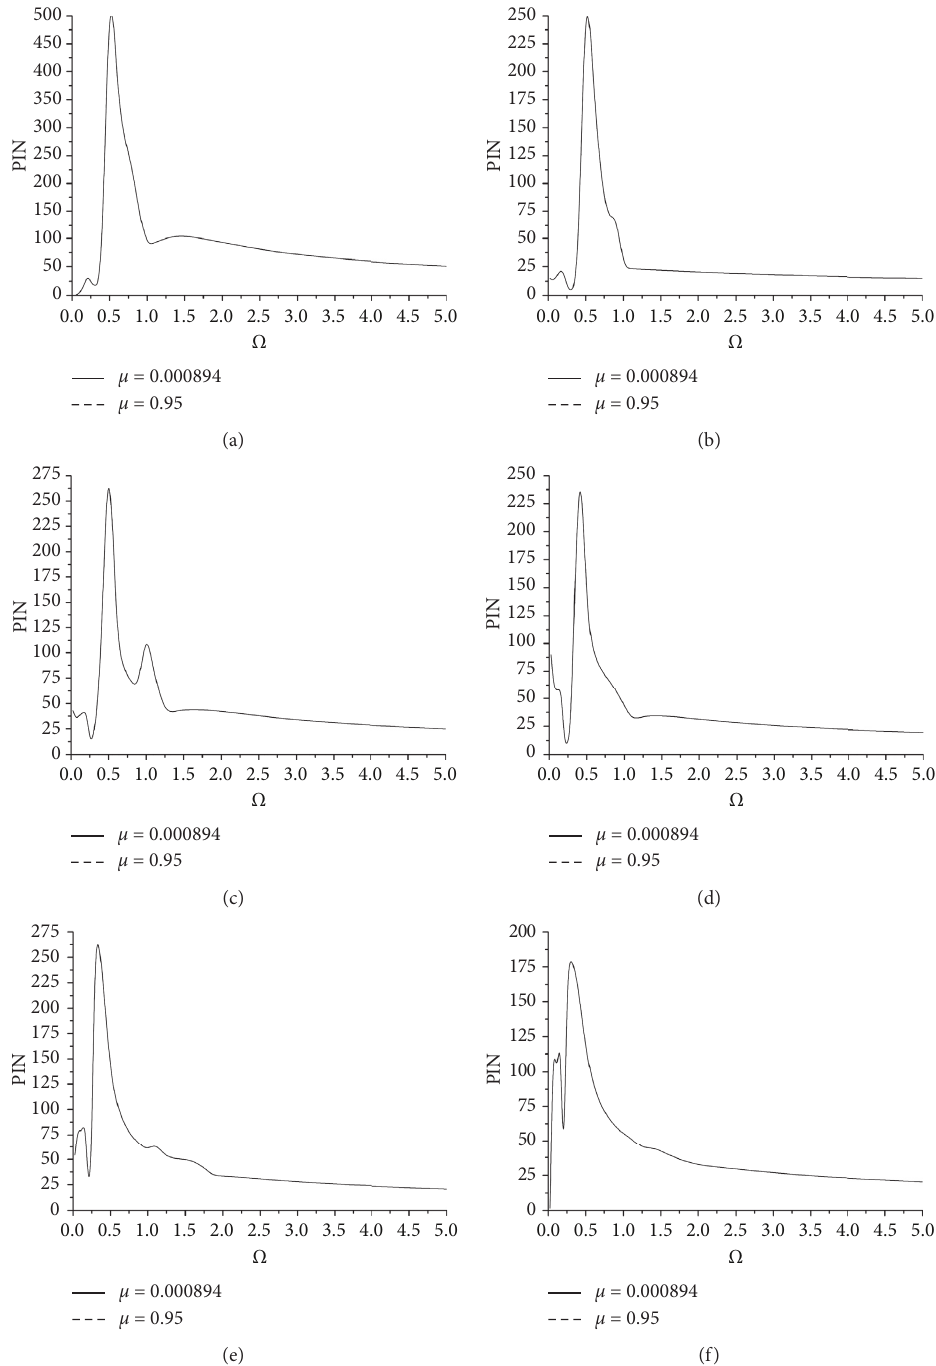
Figure 4: Input power flow under different shear coefficients of viscosity. (a) n � 0. (b) n � 1. (c) n � 2. (d) n � 3. (e) n � 4. (f) n �